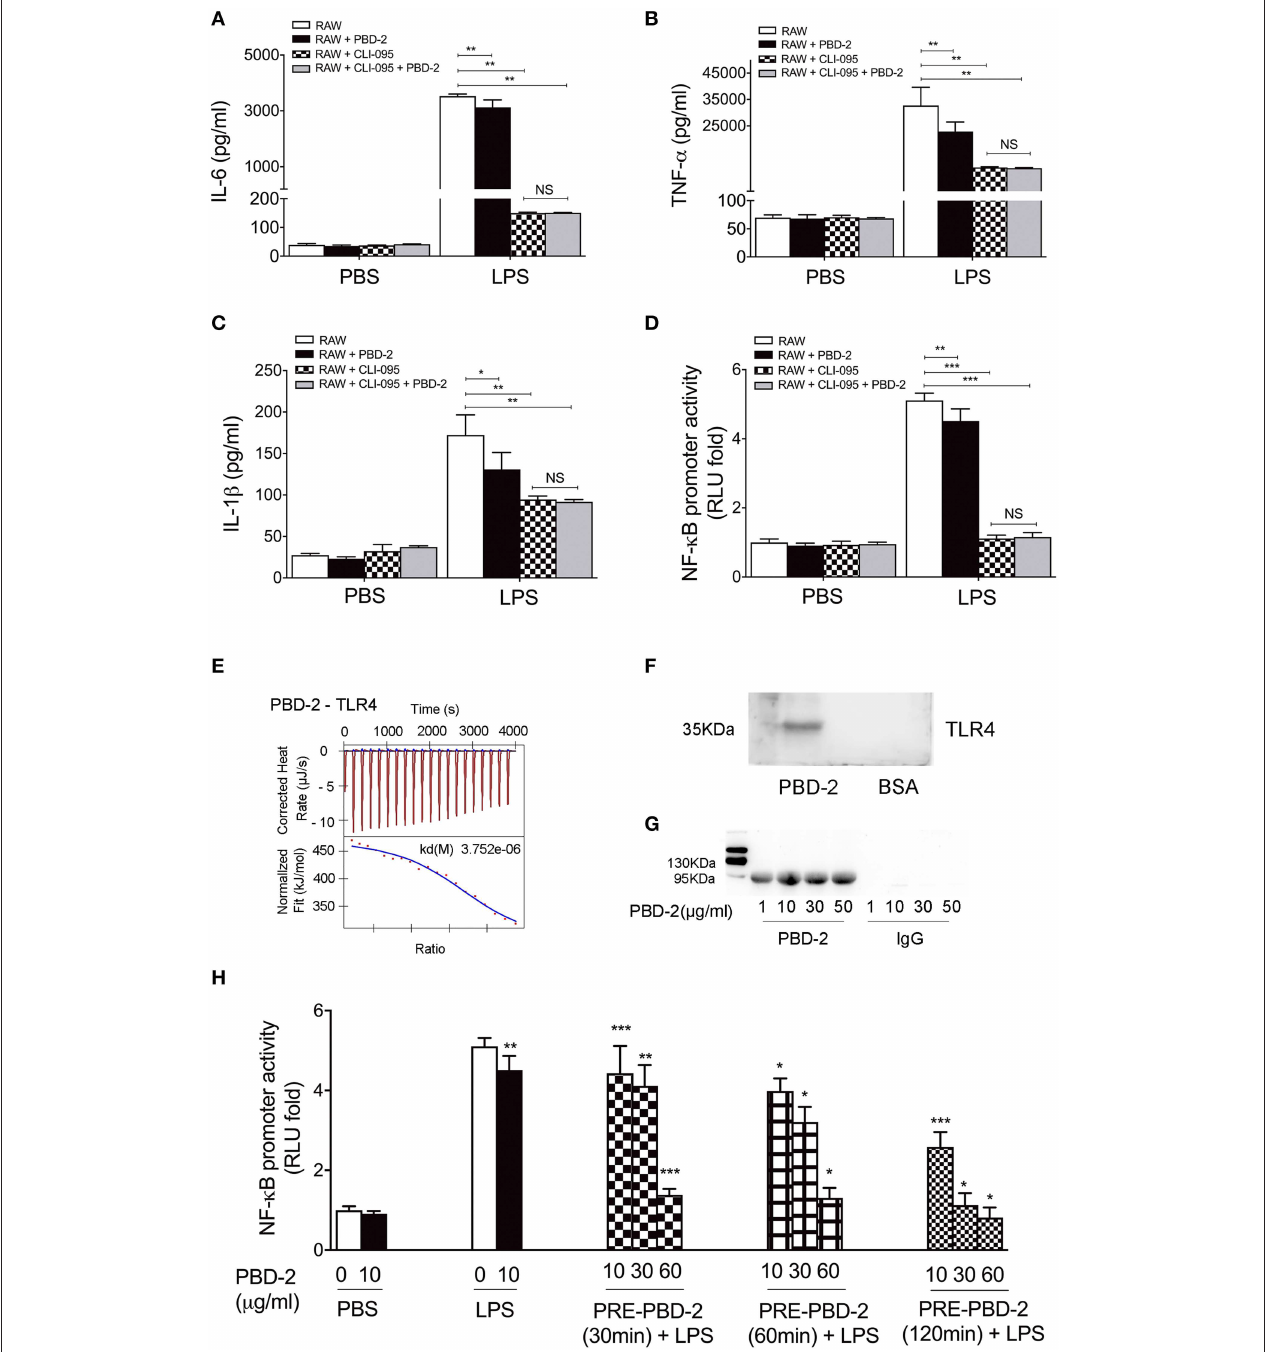
FIGURE 6 | PBD-2 could directly interact with TLR4. (A–C) RAW 264.7 cells were pre-treated with TLR4 inhibitor (CLI-095), then the cells were treated with LPS alone or together with PBD-2. Cells treated with PBS were used as negative control. Levels of proinflammatory cytokines in the supernatants of the cells were detected. (D) RAW 264.7 cells were pre-treated with TLR4 inhibitor (CLI-095) and then incubated with LPS alone or with PBD-2, and the NF- κ B promoter activity was detected by luciferase reporter assay. Cells treated with PBS were used as negative control. (E) Interaction of PBD-2 with TLR4 detected by ITC. PBS was used as negative control. (F) Interaction of PBD-2 with TLR4 detected by far-Western blot. (G) Interaction of PBD-2 with TLR4 detected by Co-IP on RAW 264.7 cells. (H) Detection of NF- κ B promoter activity after pre-incubation of PBD-2 with RAW 264.7 cells. Cells were pre-incubated with PBD-2 at 10, 30, or 60 µ g for 30, 60, or 120min (PRE-PBD-2), then LPS was supplemented and incubated with the cells. LPS was added at the same time with PBD-2 or alone as control. PBS was added instead of LPS as negative control. NF- κ B promoter activity was determined by luciferase reporter assay. Data are represented as means ± SD ( n = 6 each group). * p < 0.05, ** p < 0.01, *** p < 0.001.